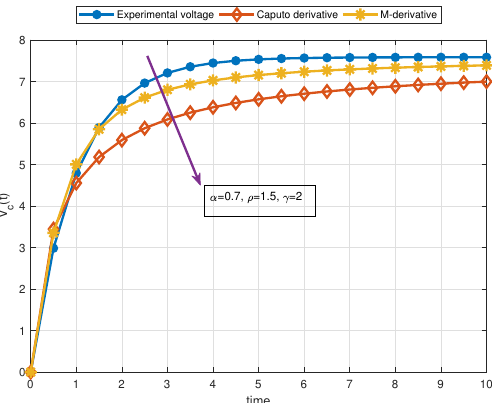
Figure 18. Comparison of the non-local M -derivative and Caputo derivative with experimental data for different values of α , ρ , and γ under the RC circuit including constant source when α = 0.7, ρ = 1.5, γ = 2, R = 10 Ω , C = 1000 F, e 0 = 7.58, and V c ( 0 ) = 0.